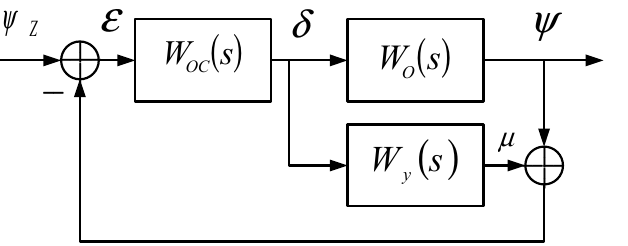
Figure 7. Modified UAV course stabilization contour.